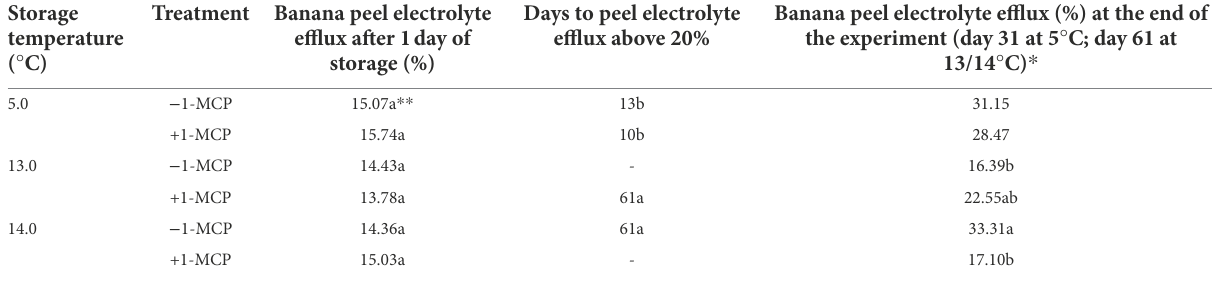
TABLE 6 Changes in electrolyte efflux (EE) of banana fruit initially treated with 0 ( − 1-MCP) or 50 μ L L − 1 (+1-MCP) aqueous 1-MCP for 60 s at 23.0 ° C and transferred to 5.0, 13.0 or 14.0 ° C storage with 95% RH ( n = 6).